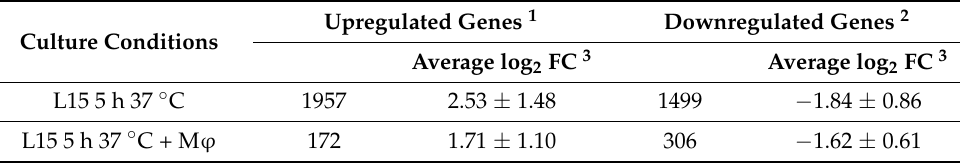
Table 1. Differentially expressed genes in the mcwc -1a ∆ mutant strain compared to the wild-type